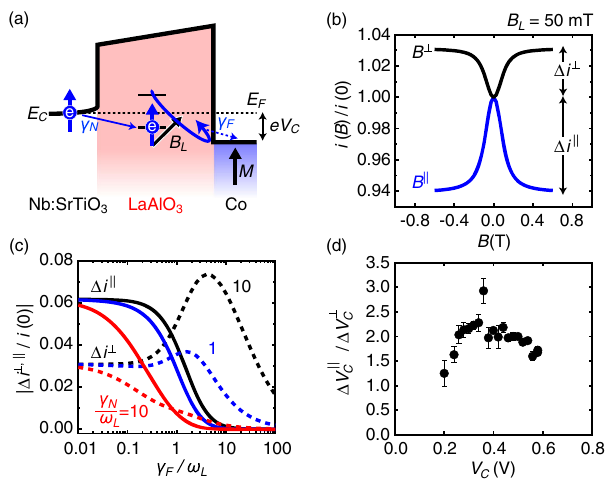
FIG. 4. Spin-dependent hopping as the origin for junction magnetoresistance. (a) Schematic diagram for electron hopping through a single defect between a FM and NM contact in the electron-extraction regime. The schematic is drawn for optimally dipole tuned Co = LaAlO 3 = Nb ∶ SrTiO 3 near the flat-band con- dition. (b) Calculated magnetic field dependence of the hopping current through a localized state. The linewidth is determined by the local fields acting upon the defect site, here plotted for ¼ 50 mT ≈ Δ B= 2 , which reproduces the experimental line- B L widths. (c) Dependence of the anisotropic components Δ i ⊥ ; ∥ on ¼ g μ B = ℏ . Solid the tunnel coupling rate ( γ ) normalized to ω F L B L lines represent B ∥ and dashed lines B ⊥ at different values of the coupling ( γ ) between the defect state and the Nb ∶ SrTiO 3 . N = Δ V ⊥ (d) Measured anisotropy Δ V ∥ as a function of bias for C C ¼ 2 u : c t LAO